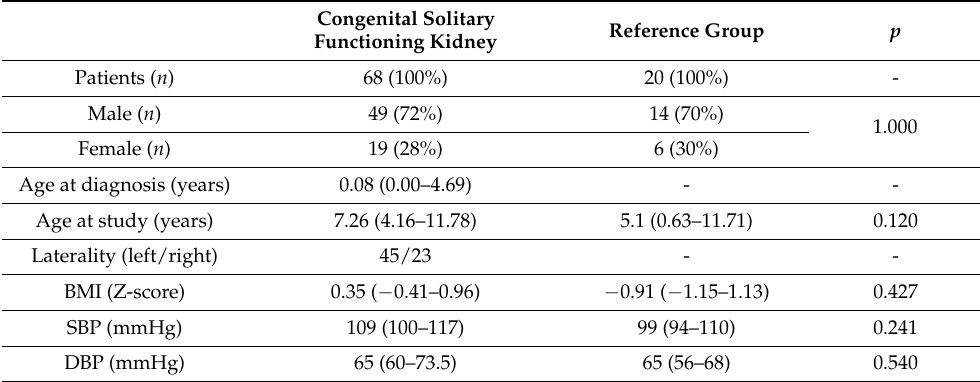
Table 1. Clinical characteristics of patients with a solitary functioning kidney and the reference group.